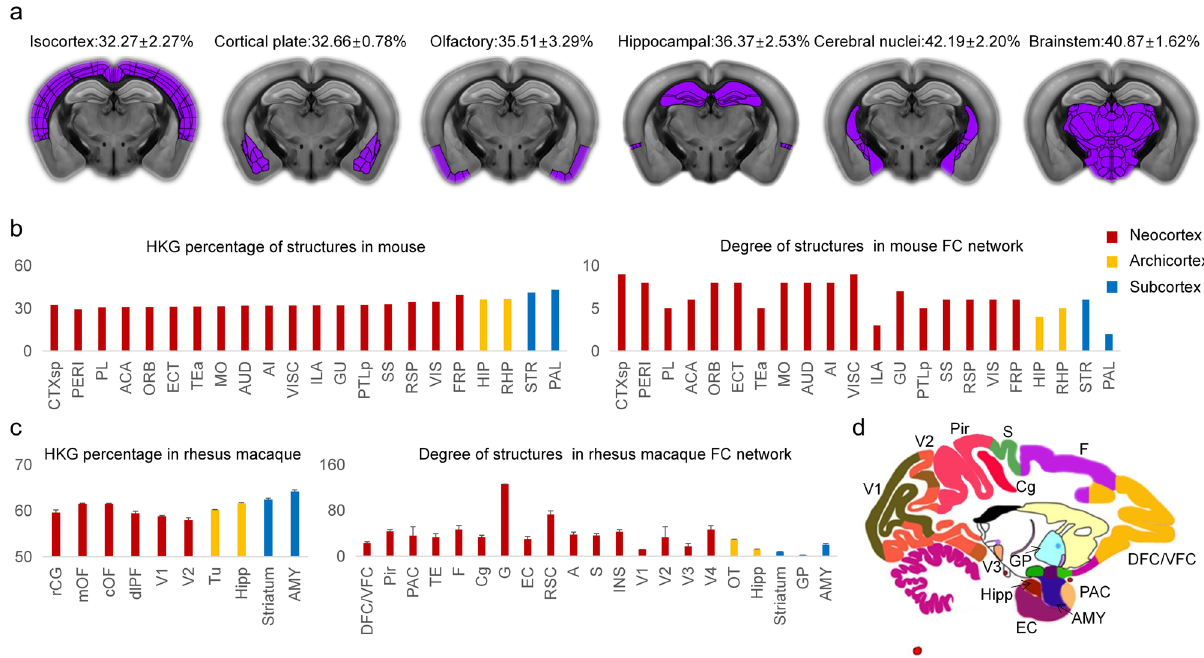
Fig. 5 Comparison of the gene expression network and the functional connectivity network in mouse and rhesus macaque brains. a The HKG percentages mapped to the regions of the mouse brain. The HKG percentage in the neocortex is lower than those in the archicortex (including the olfactory area and hippocampal formation) and subcortex (cerebral nuclei and brainstem). The regions of interest are marked in purple. All hybridization images were obtained from the Allen Mouse Brain Atlas. b HKG percentage of gene expression and the degree of functional connectivity in the structures of the mouse brain. c The HKG percentage of gene expression and the degree of functional connectivity in the structures of rhesus macaque brains. d Diagram of the main structures in the rhesus macaque brain. This picture is generated based on the D99 brain template 74 . The description of brain structures can be found in Supplementary